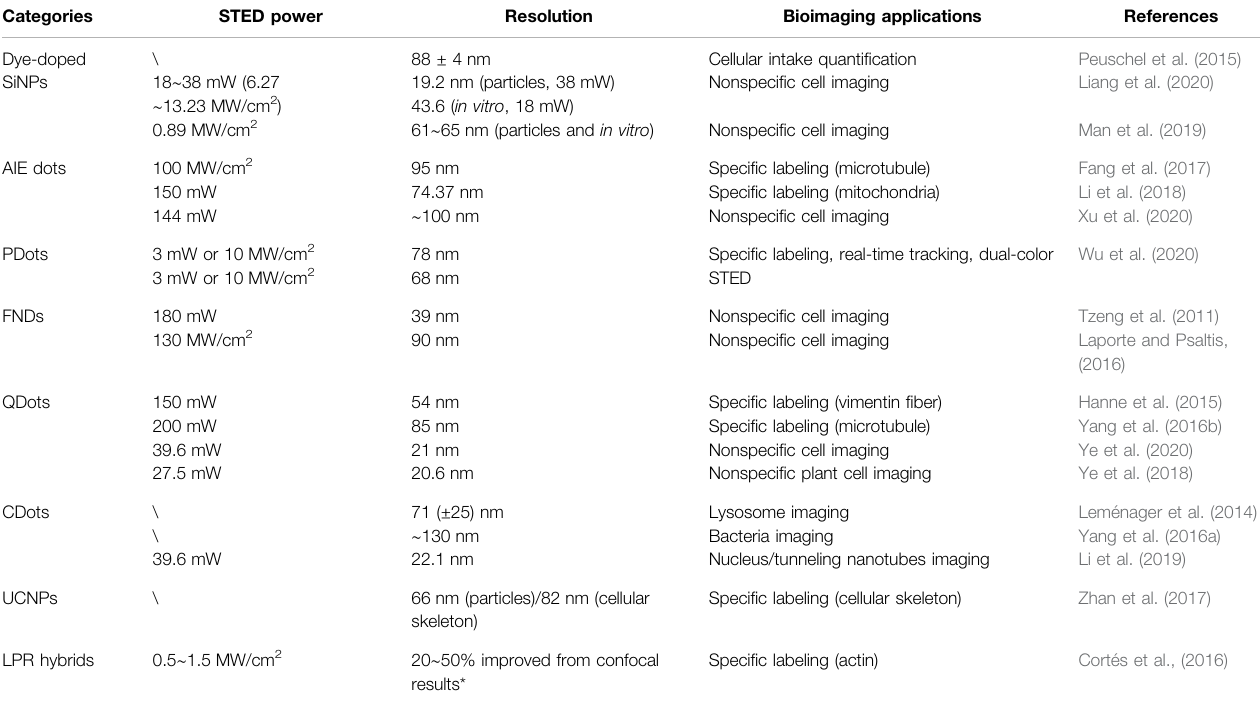
TABLE 4 | Summary of representative works on STED nanoprobes for